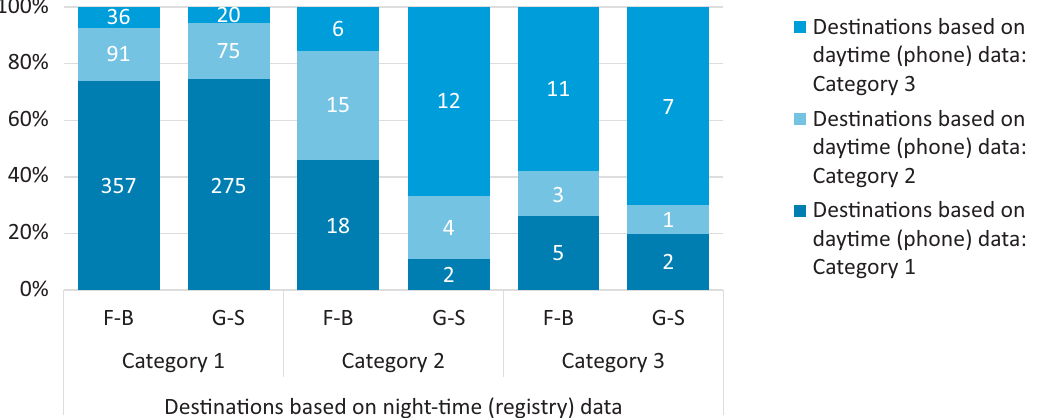
Figure 7. Comparison of the categorization of destinations based on registry data (night-time population) vs. phone data (daytime population). Note: 28 March 2019,